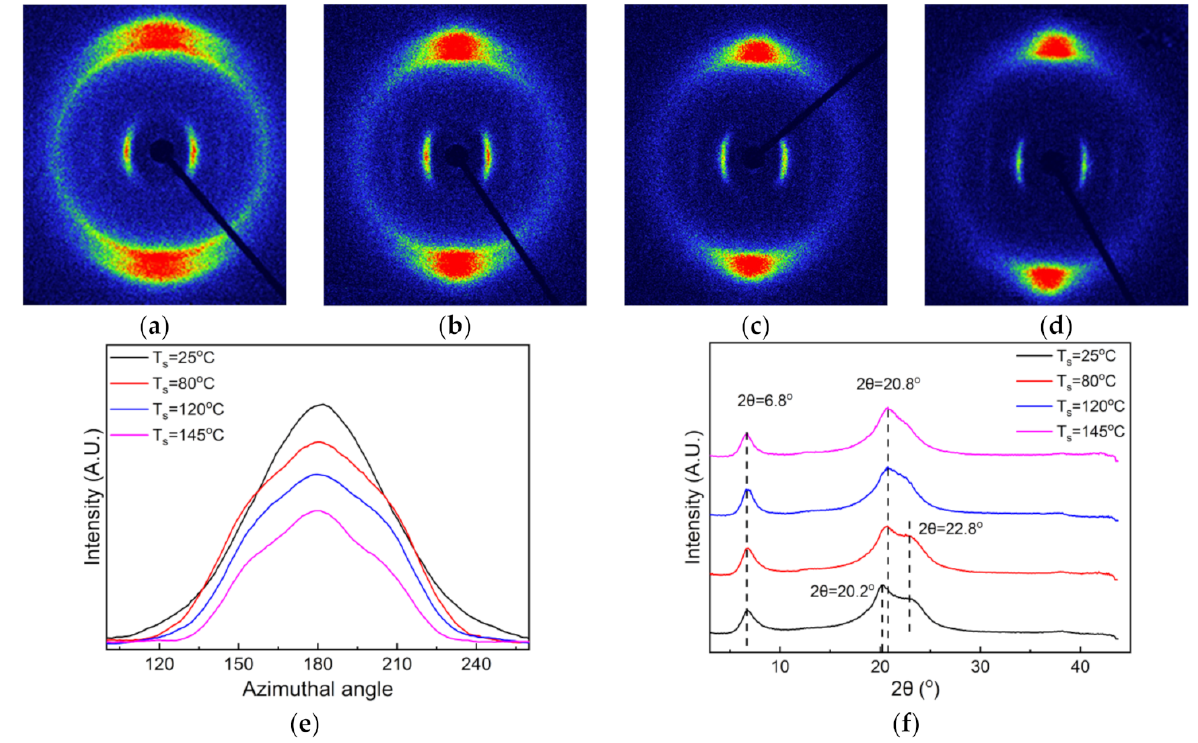
Figure 4. ( a – d ) 2D-WAXD patterns of the nylon-11 films stretched at different temperatures: ( a ) 25 ◦ C, ( b ) 80 ◦ C, ( c ) 120 ◦ C and ( d ) 145 ◦ C; ( e ) azimuthal intensity distributions of the (001) reflection, and ( f ) diffraction intensity profiles derived from the 2D-WAXD